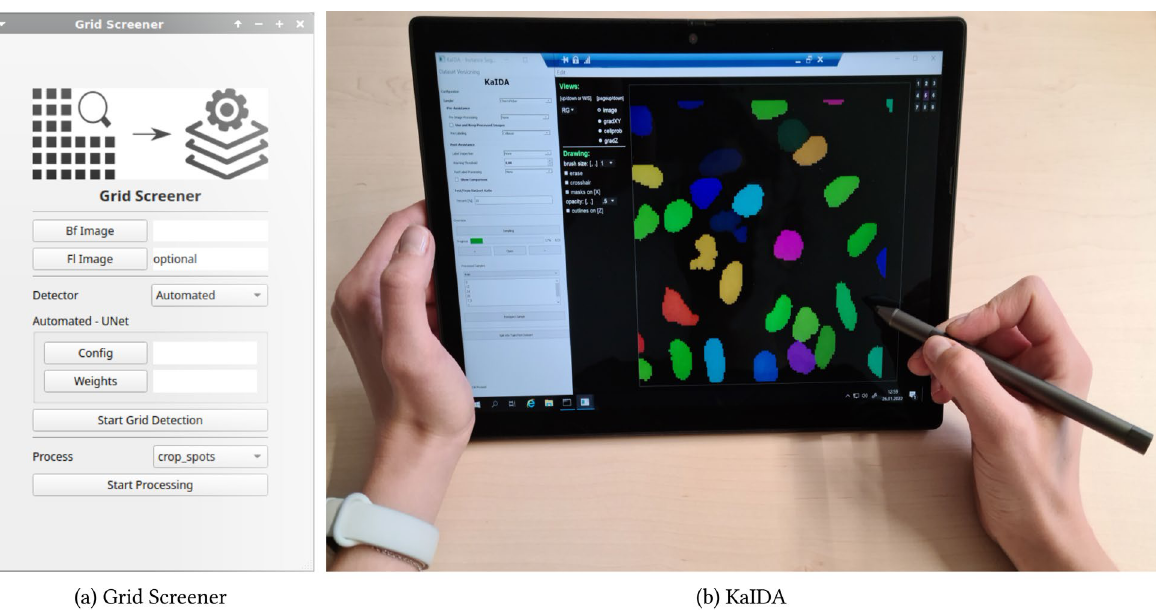
Figure 8. Overview GUIs. The GUI of Grid Screener 32 ( a ) is shown. Besides, the usage of KaIDA 20 , integrated into a Lenovo x12 Detachable mobile touchscreen device ( b ) is